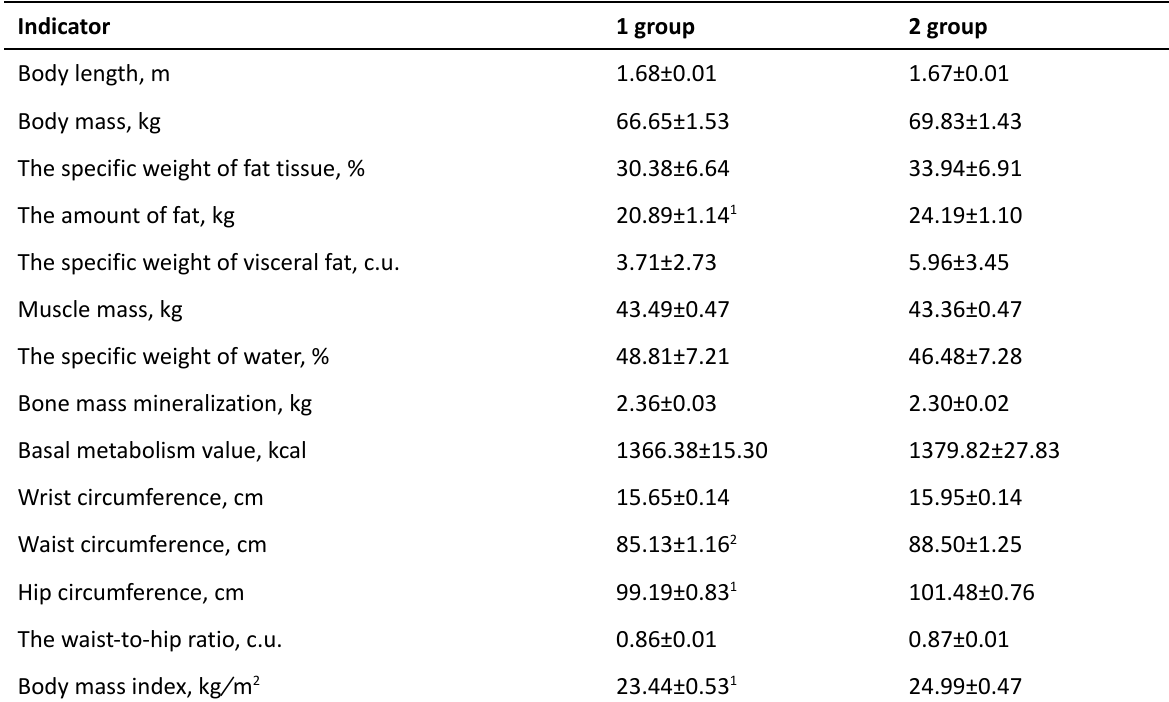
Table 1. Indicators of physical development and somatotype of girls and women involved in fitness